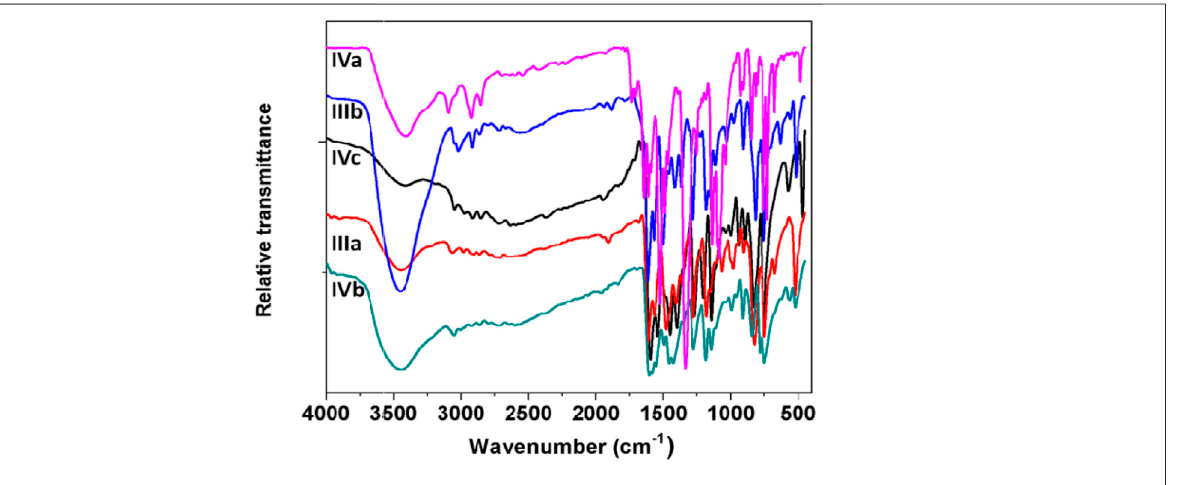
FIGURE 3 | FT-IR spectra of IIIa , IIIb , and VIa-c precursors.